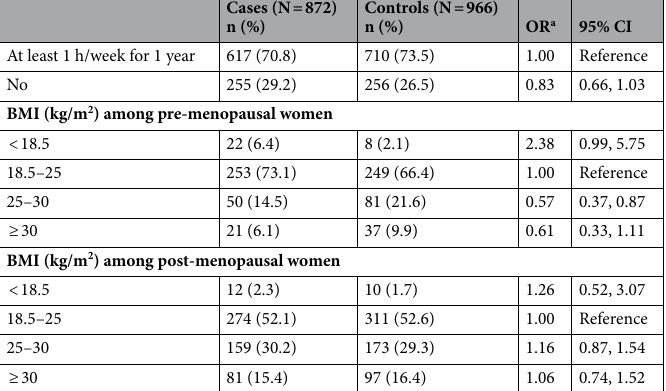
Table 1. Characteristics of the study population and odds ratios associated with well-established breast cancer risk factors. The CECILE study, France, 2005–2007. *Matching variables. FTP full term pregnancy, FFTP first full-term pregnancy, MHT menopausal hormonal treatment, BMI body mass index, OR odds ratio, CI confidence interval. a Odds ratios adjusted for all variables in the